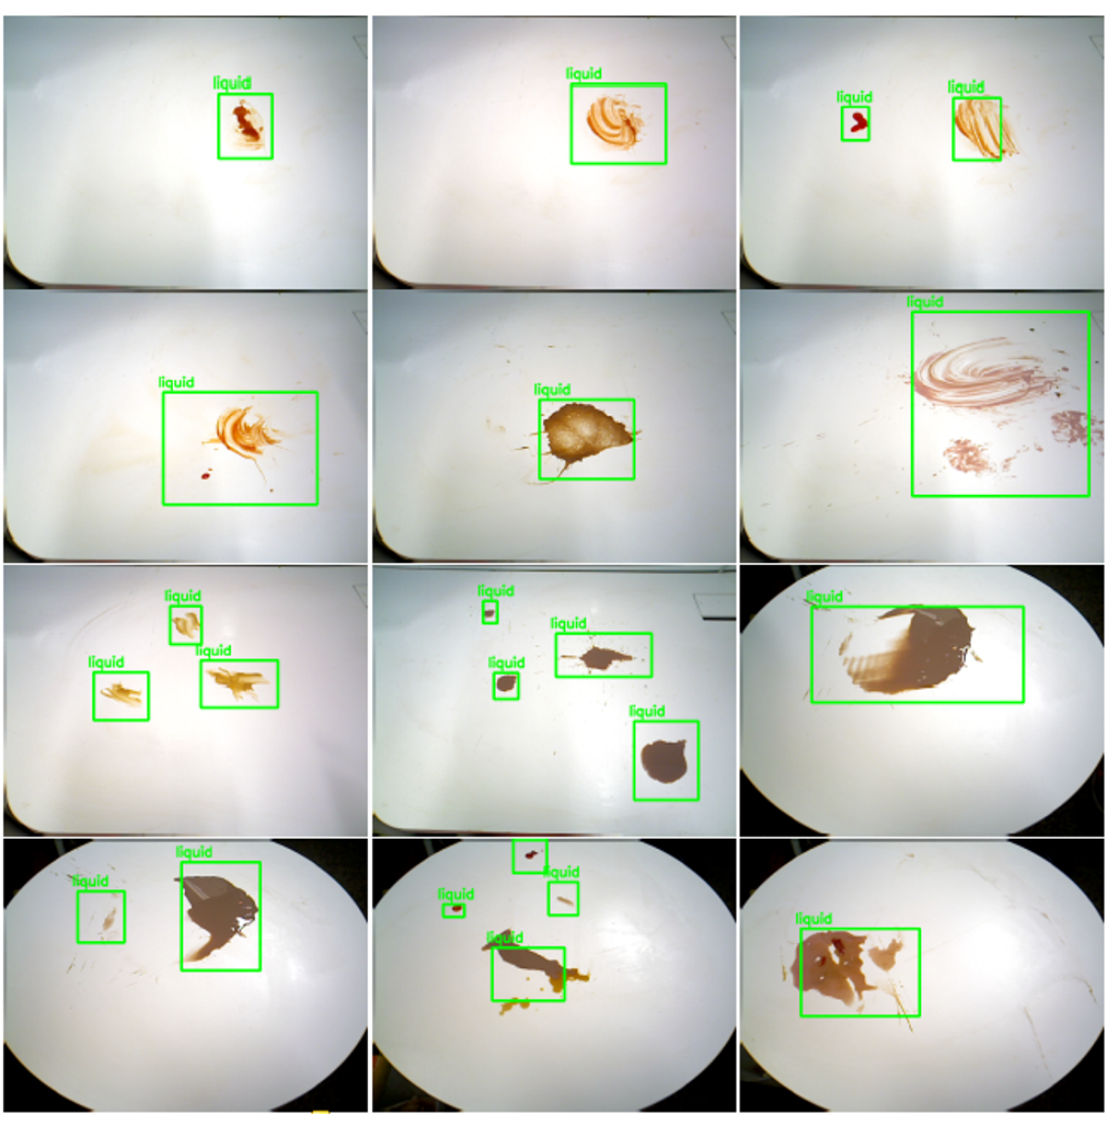
Figure 8. Liquid spillage and stains detection